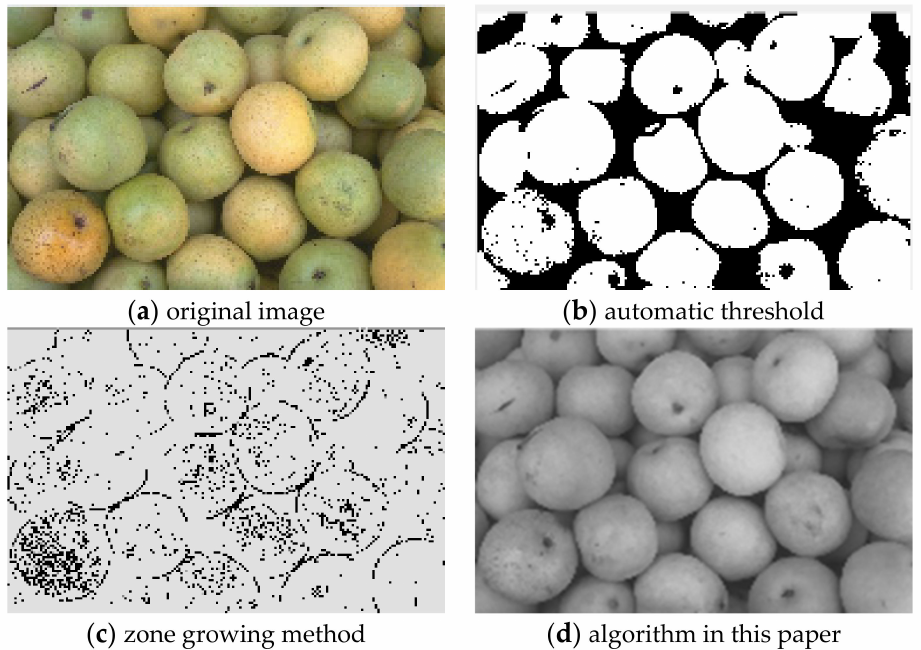
Figure 4. Comparison of Pear image segmentation results. For the comparison of the three algorithms on Football images, the experimental results are shown in Figure 5.